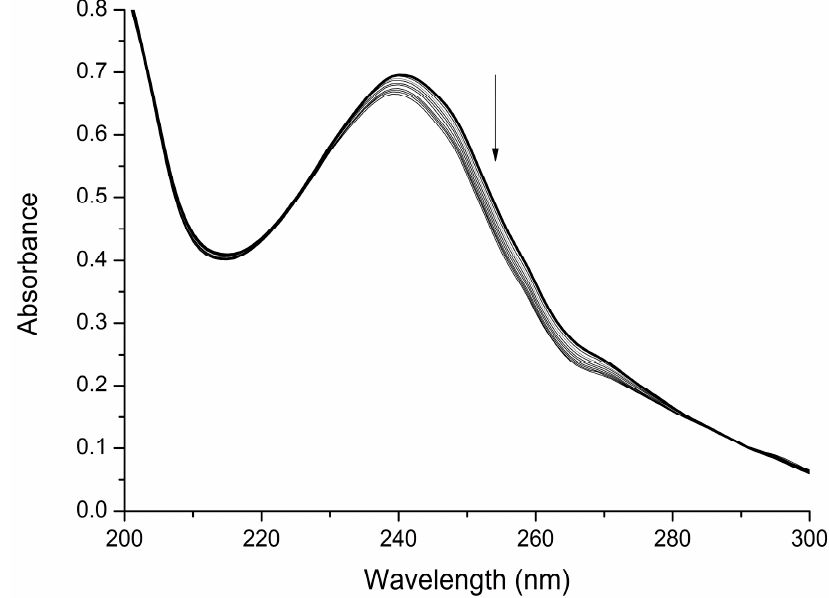
Figure 4. UV-vis titration of ligand 10d (bold line, compound alone) with increasing amount of Mg(CH 3 COO) 2 . The arrow indicates the direction of absorbance change as Mg(CH 3 COO) 2